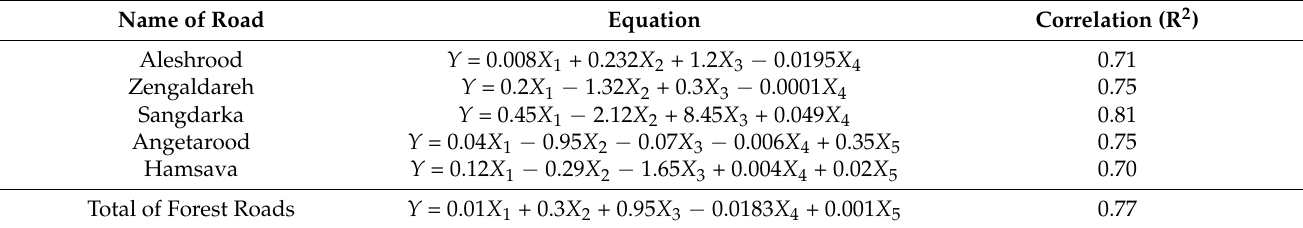
Table 6. Combined Regression Equation for Five Districts and Total